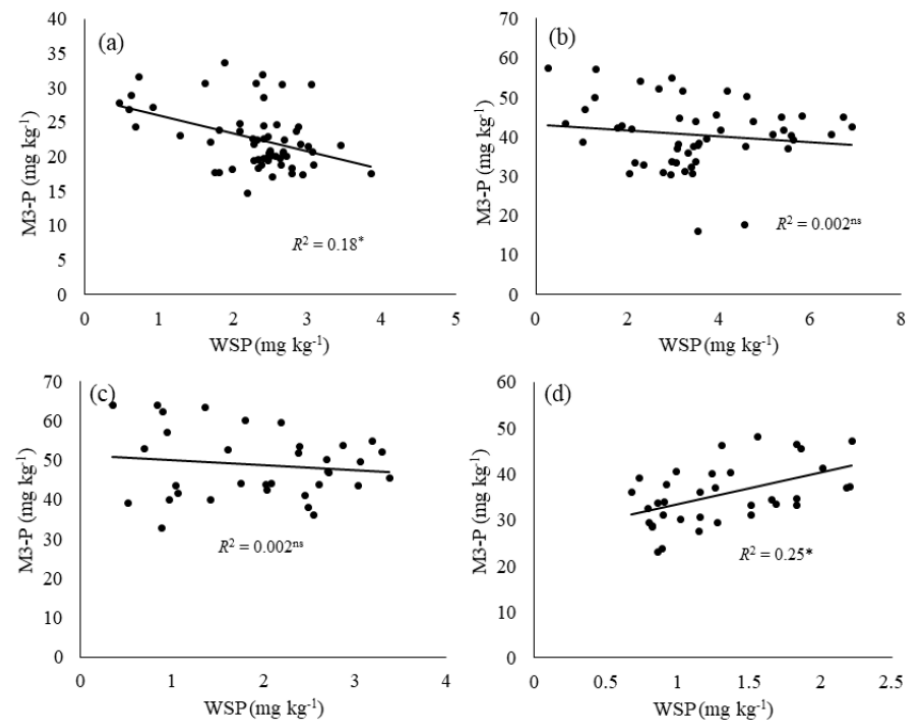
Figure 5. Relationship between soil water-soluble phosphorus (WSP) and Mehlich-3 phosphorus (M3-P) for each location: ( a ) Chickasha, ( b ) Efaw, ( c ) Lahoma, and ( d ) Perkins. Total soil P was constant within each location. *: indicates significance at p < 0.05, for the second-order linear regression model. ns: not significant.